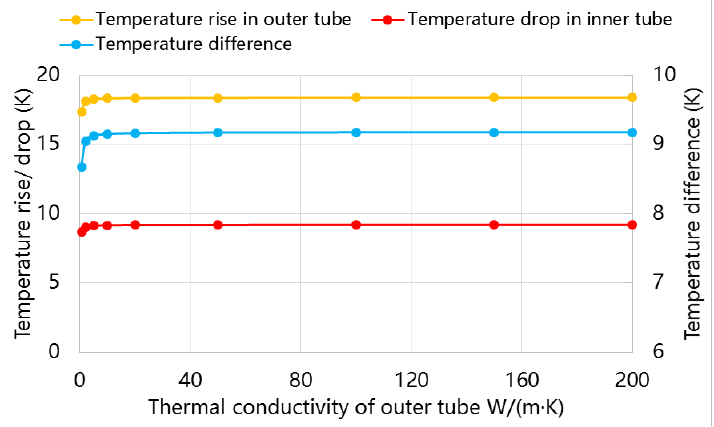
Figure 20. Effect of thermal conductivity of outer pipe on the water temperature